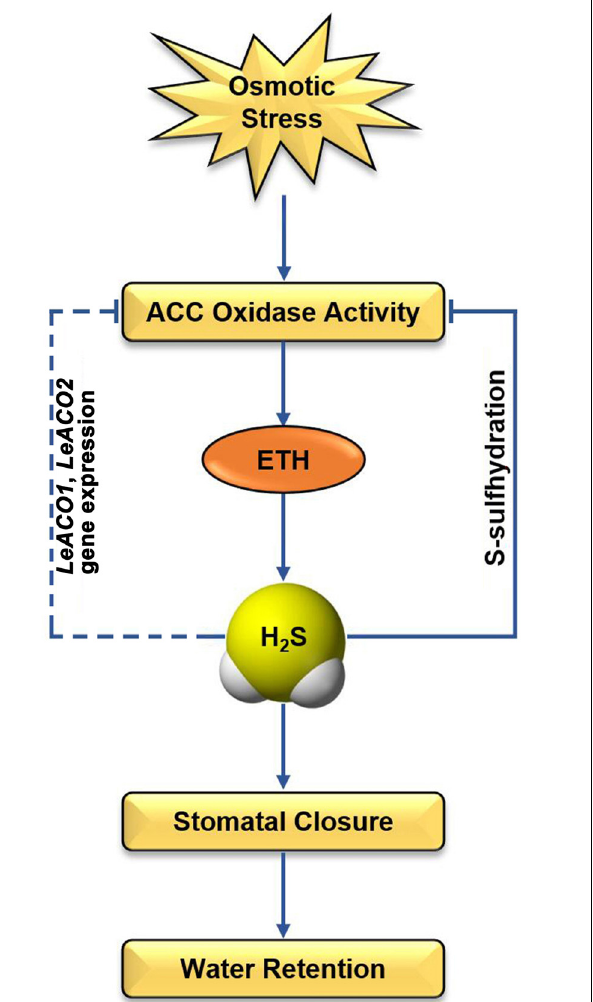
FIGURE 7 | Schematic diagram illustrating the proposed signaling regulation of ethylene-induced H 2 S negatively regulates ethylene biosynthesis in tomato. Arrows indicate enhanced effects and hyphens indicate suppressed